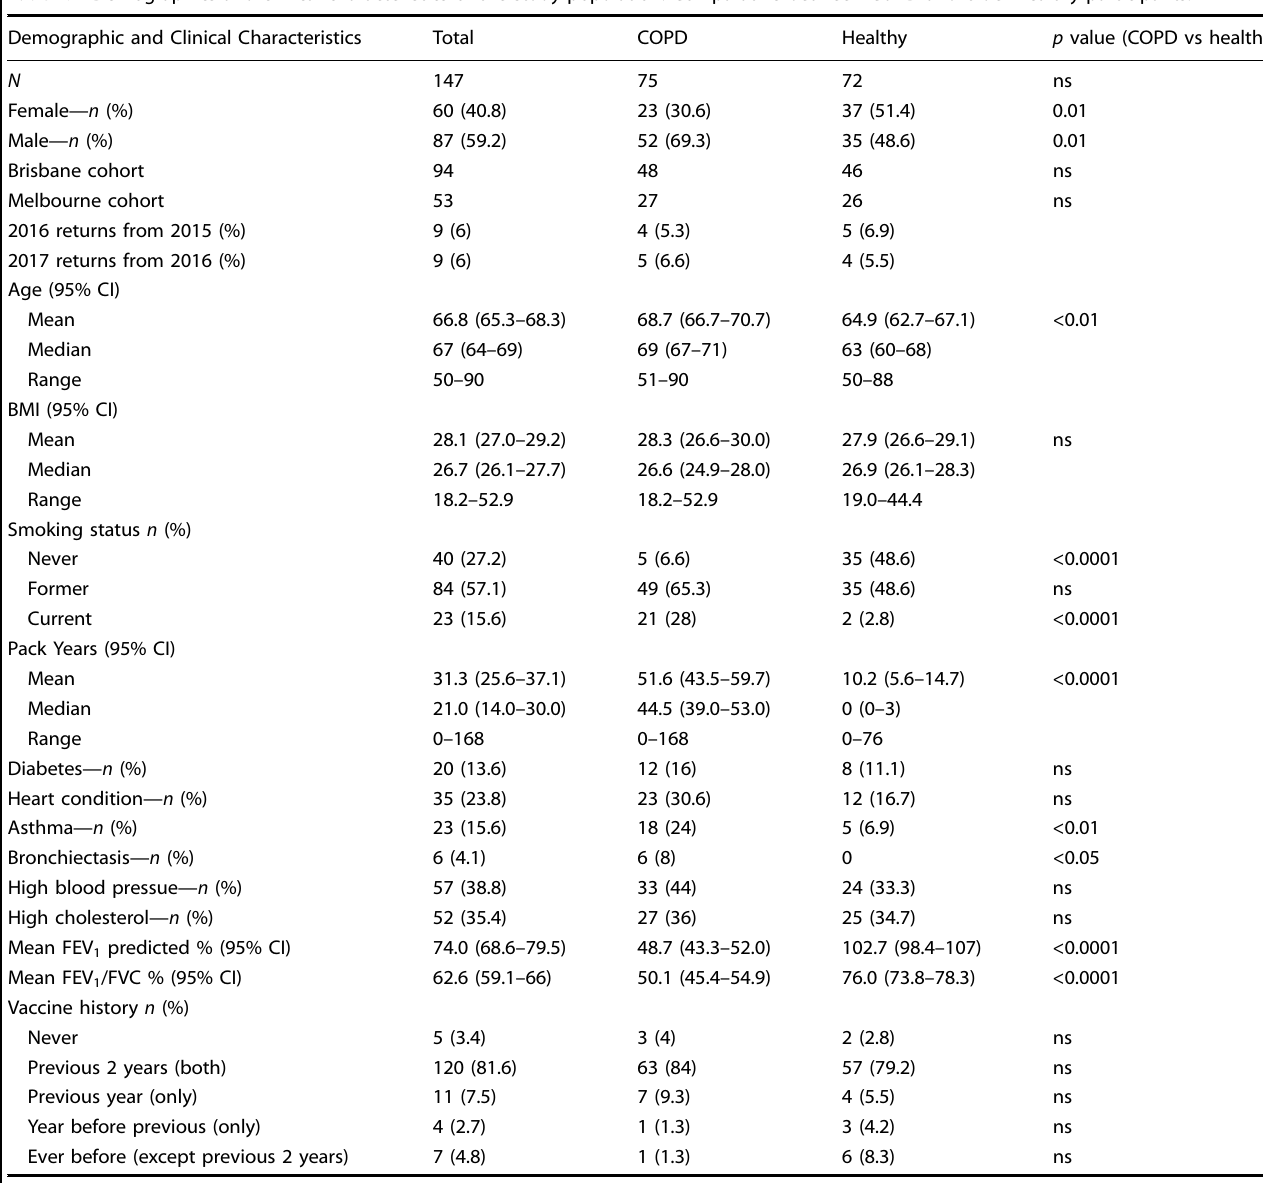
Table 2. Demographics and clinical characteristics of the study population: Comparative between COPD and older healthy participants. Demographic and Clinical